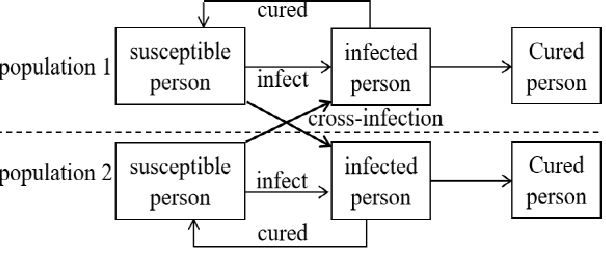
Int. J. Environ. Res. Public Health 2020 , 17 , x FOR PEER REVIE Figure 1. The transmission process of infectious diseases between two populations.